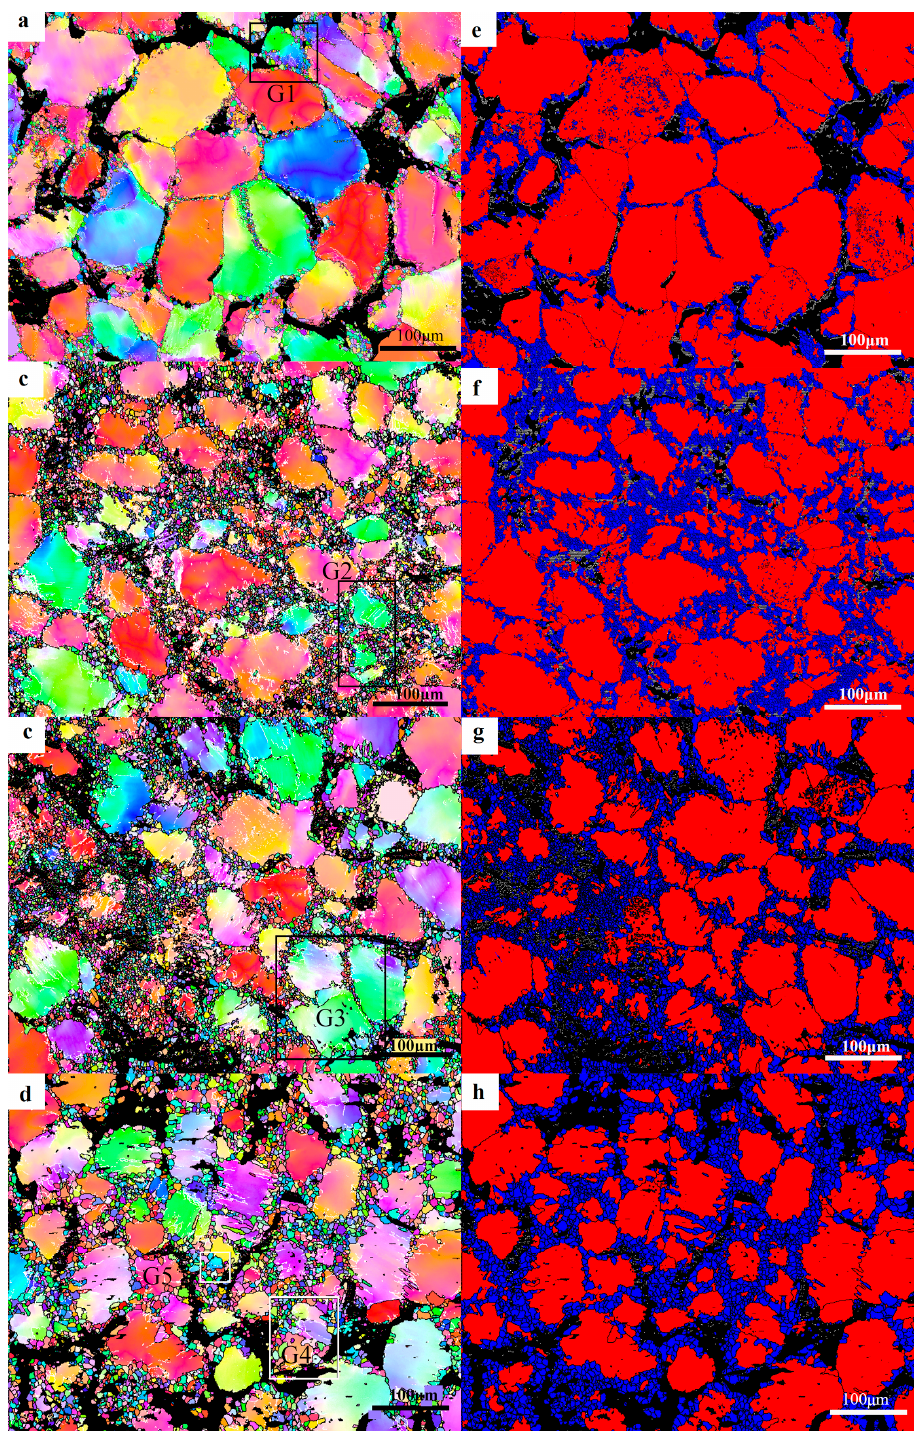
Figure 5. ( a – d ) are the inverse polar figure of strain rates 0.5–0.001 s − 1 respectively, and ( e – h ) are the dynamic recrystallized grain (DRX) figures corresponding to ( a – d ), respectively.